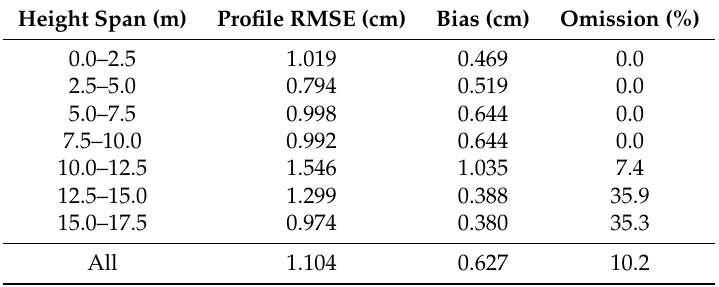
Table 7. Stem profile diameter RMSE and omission errors for different height spans of the trees in Plots 1–6 at the Svartberget test site. The parameter settings used in the stem profile detection method were: voxel size of 3 cm, curvature weight of 0.75 and cluster weight of 15. The total number of manually-calipered stem profile diameters is